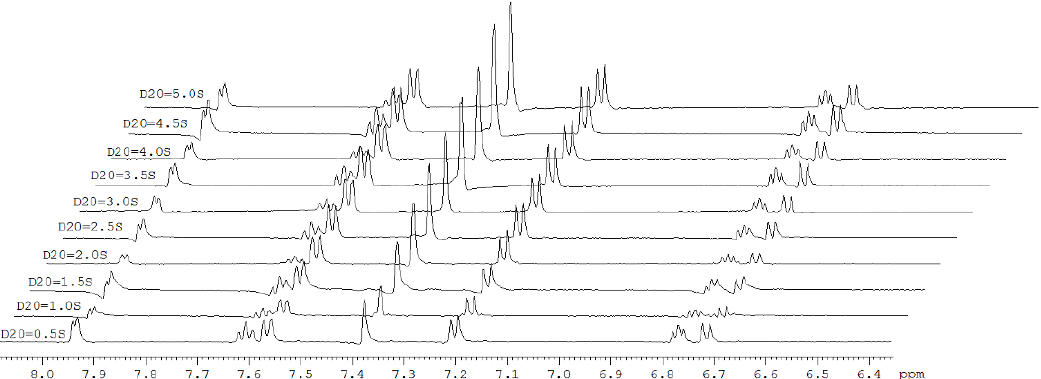
Figure 3. Stack plot of STD-NMR (2-aminopyridine and isovanillin with BSA) spectra at varying saturation times (0.5 s to 5.0 s). The STD-NMR spectra were performed with 50 µM BSA (~67-KDa) in phosphate buffer pH 7.4 solution, with 5 mM solution of 2-aminopyridine and isovanillin each in 5% DMSO with 95% D O. Further details can be found in experimental section. 2